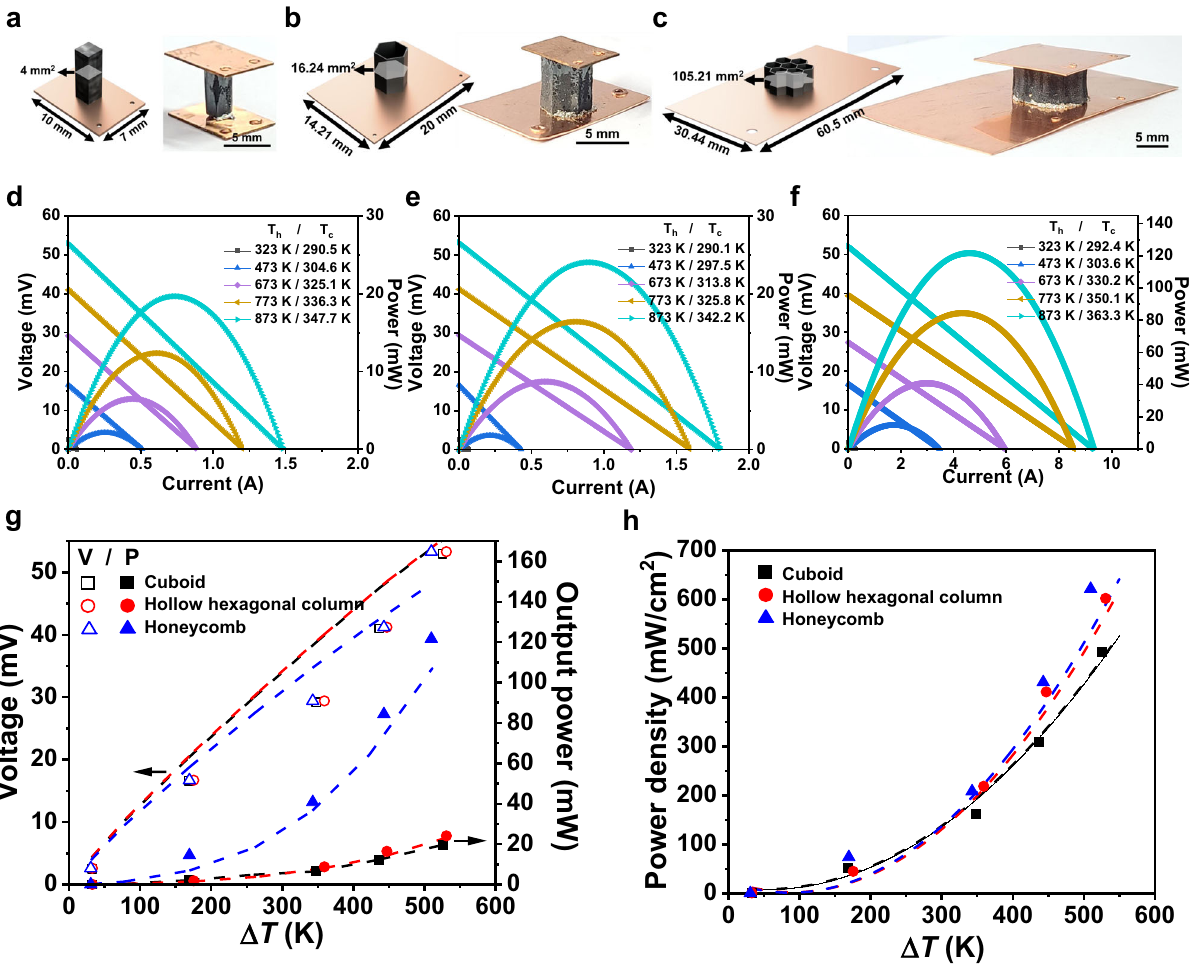
Fig. 5 power-generating TEG with 3D-printed cellular honeycomb material. a – c 3D illustrated models and photograph of TEGs chipped with ( a ) cuboid-, ( b ) hollow hexagonal column-, and ( c ) honeycomb-shaped Cu 2 Se TE legs. d – f Output voltages and powers of ( d ) cuboid-, ( e ) hollow hexagonal column-, and ( f ) honeycomb-shaped Cu 2 Se TE legs at the hot side temperatures ranging from 323 to 873 K. g Output voltages and powers, and h power densities of TEGs as a function of the temperature differences. The points and the dotted lines in the panels of ( g ) and ( h ) are the measured values and the predicted values by the FEM